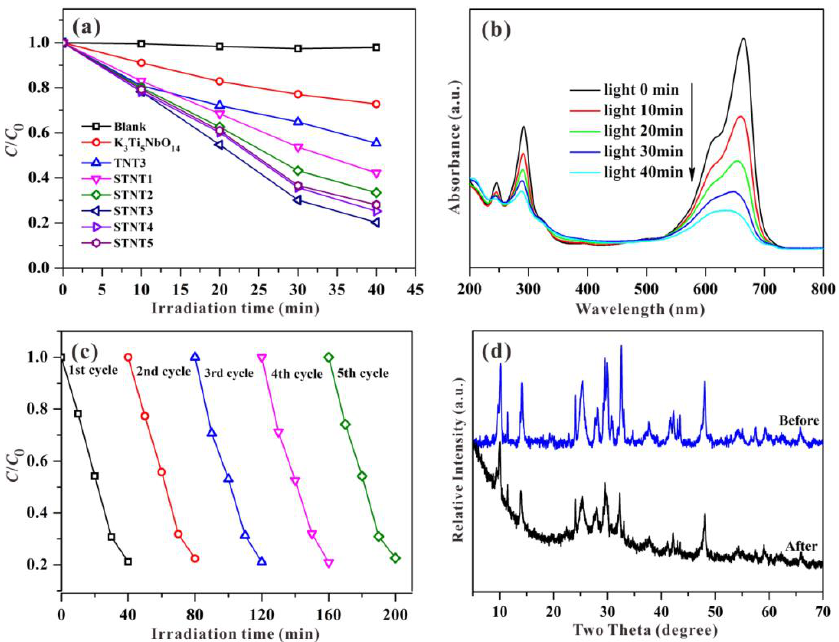
Figure 7. ( a ) Visible-light-driven photocatalytic degradation rate of MB solution over different samples. ( b ) UV-visible spectral changes, ( c ) recycling experiments, and ( d ) XRD patterns before and after five cycles over STNT3 for the photocatalytic degradation of MB.